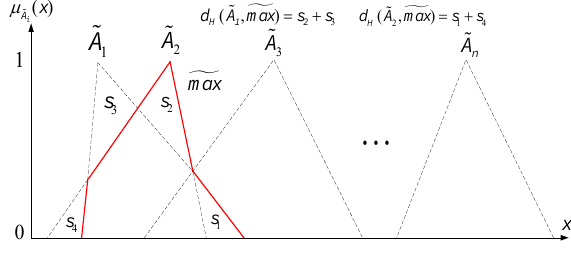
Figure 2. Triangular fuzzy number and maximum fuzzy